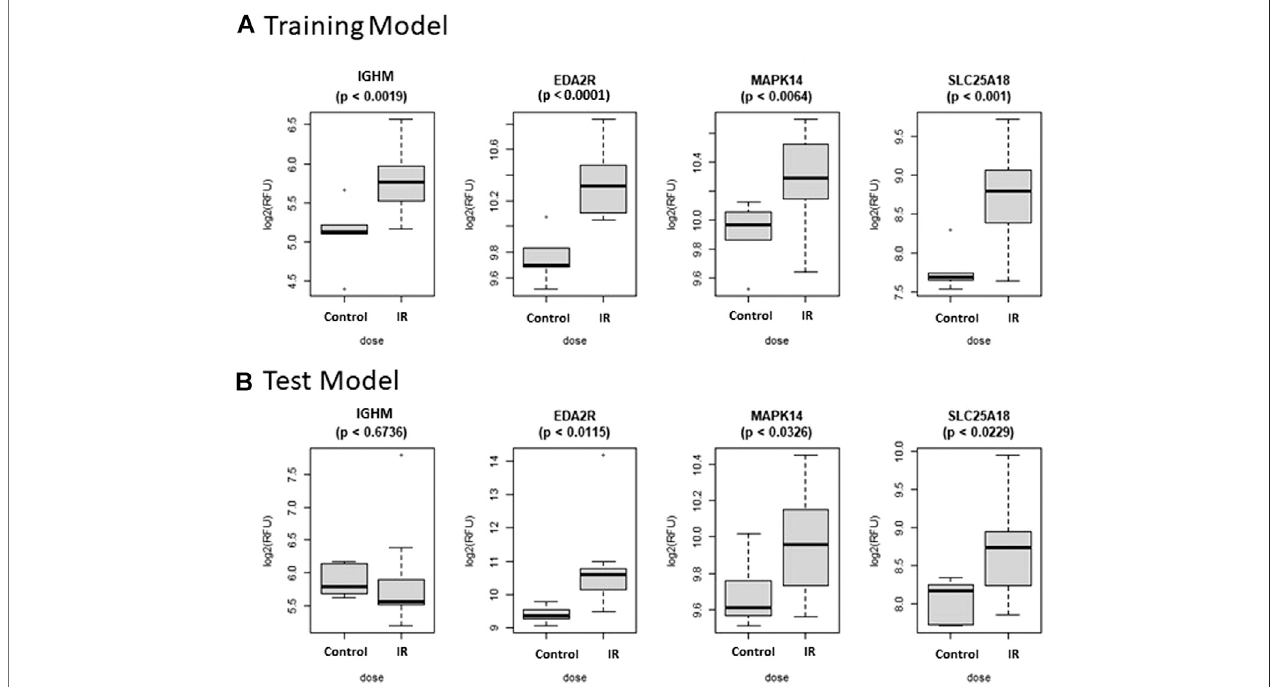
FIGURE3| ComparisonofSelectedProteinsinControlvs.RTModel.Individualbiomarkerexpression pro fi lesforeachControlvs.RTModelproteinareshown for the sample sets used for both the (A) Training and (B) Test models.